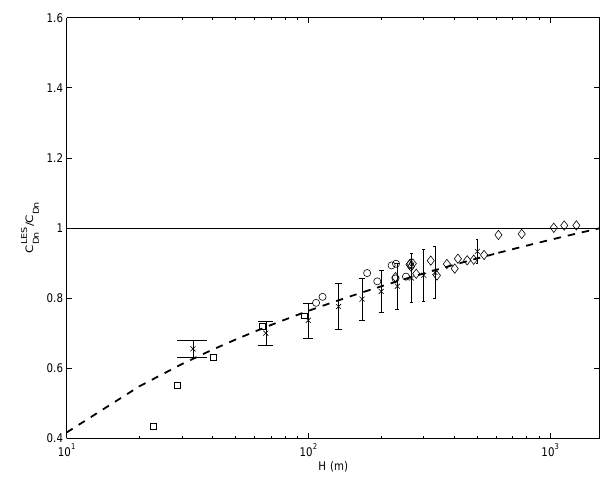
/C Charnok from Lange et D D